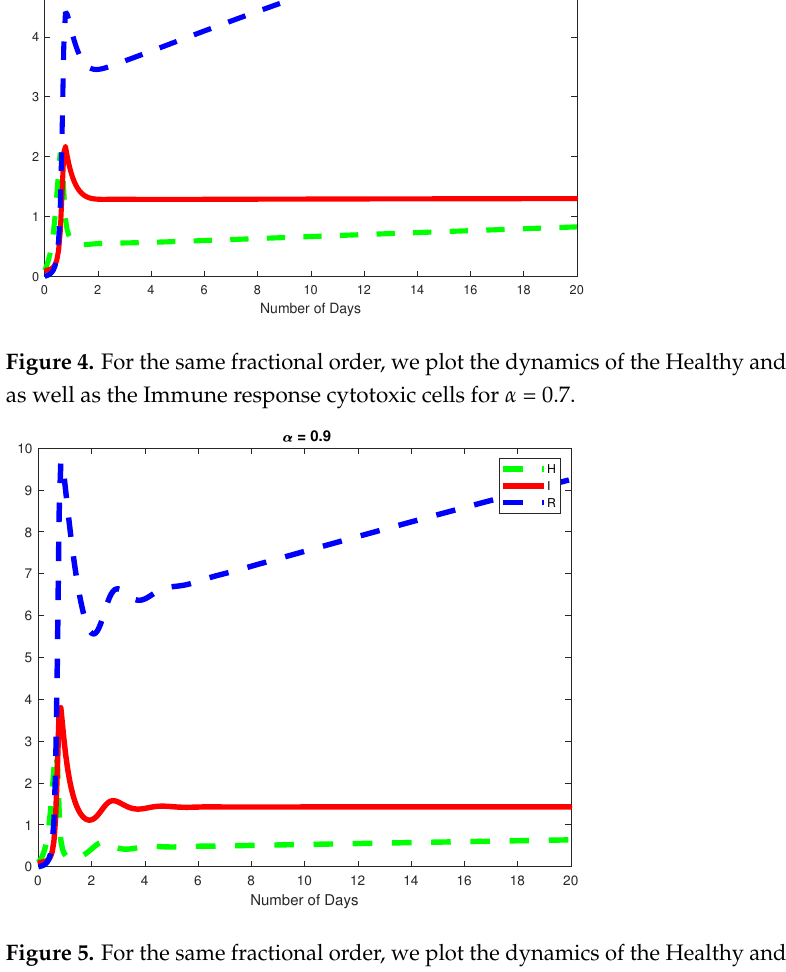
Figure 5. For the same fractional order, we plot the dynamics of the Healthy and Infected Hepatocyte as well as the Immune response cytotoxic cells for α =